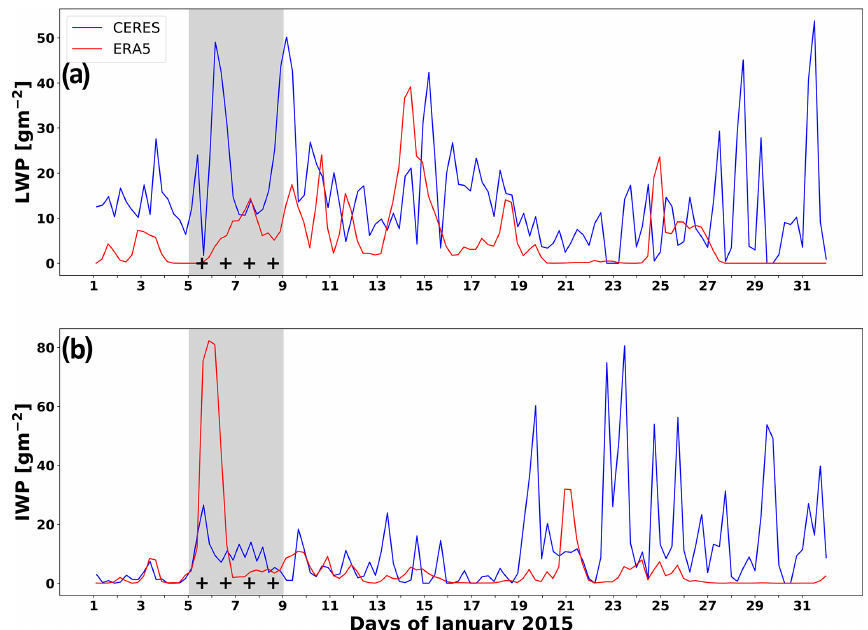
Figure 5. Time series of hourly cloud LWP (a) and IWP (b) from the CERES SYN1deg data product (red) and ERA5 (blue), over the Siple Dome region throughout January 2015. Black crosses denote the satellite evening overpass times.